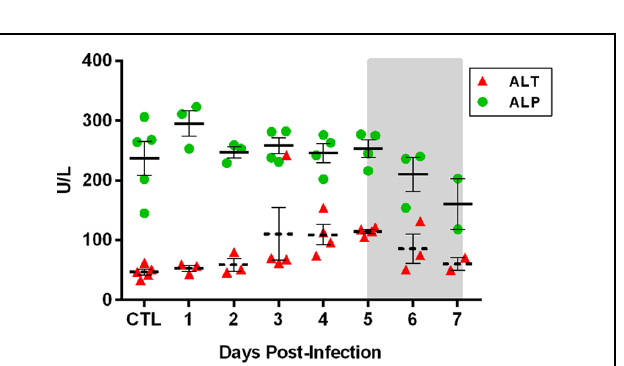
FIGURE 6 | Changes in blood cells over the course of infection. The arrow represents a significant decrease in blood lymphocytes at that time point, as measured by t -test. The black box represents the time point at which both granulocytes and platelets differ significantly from controls (as measured by ANOVA with multiple comparison test), and these differences persist through the end of infection. The gray shaded box represents the window of clinical disease (5–7 dpi).